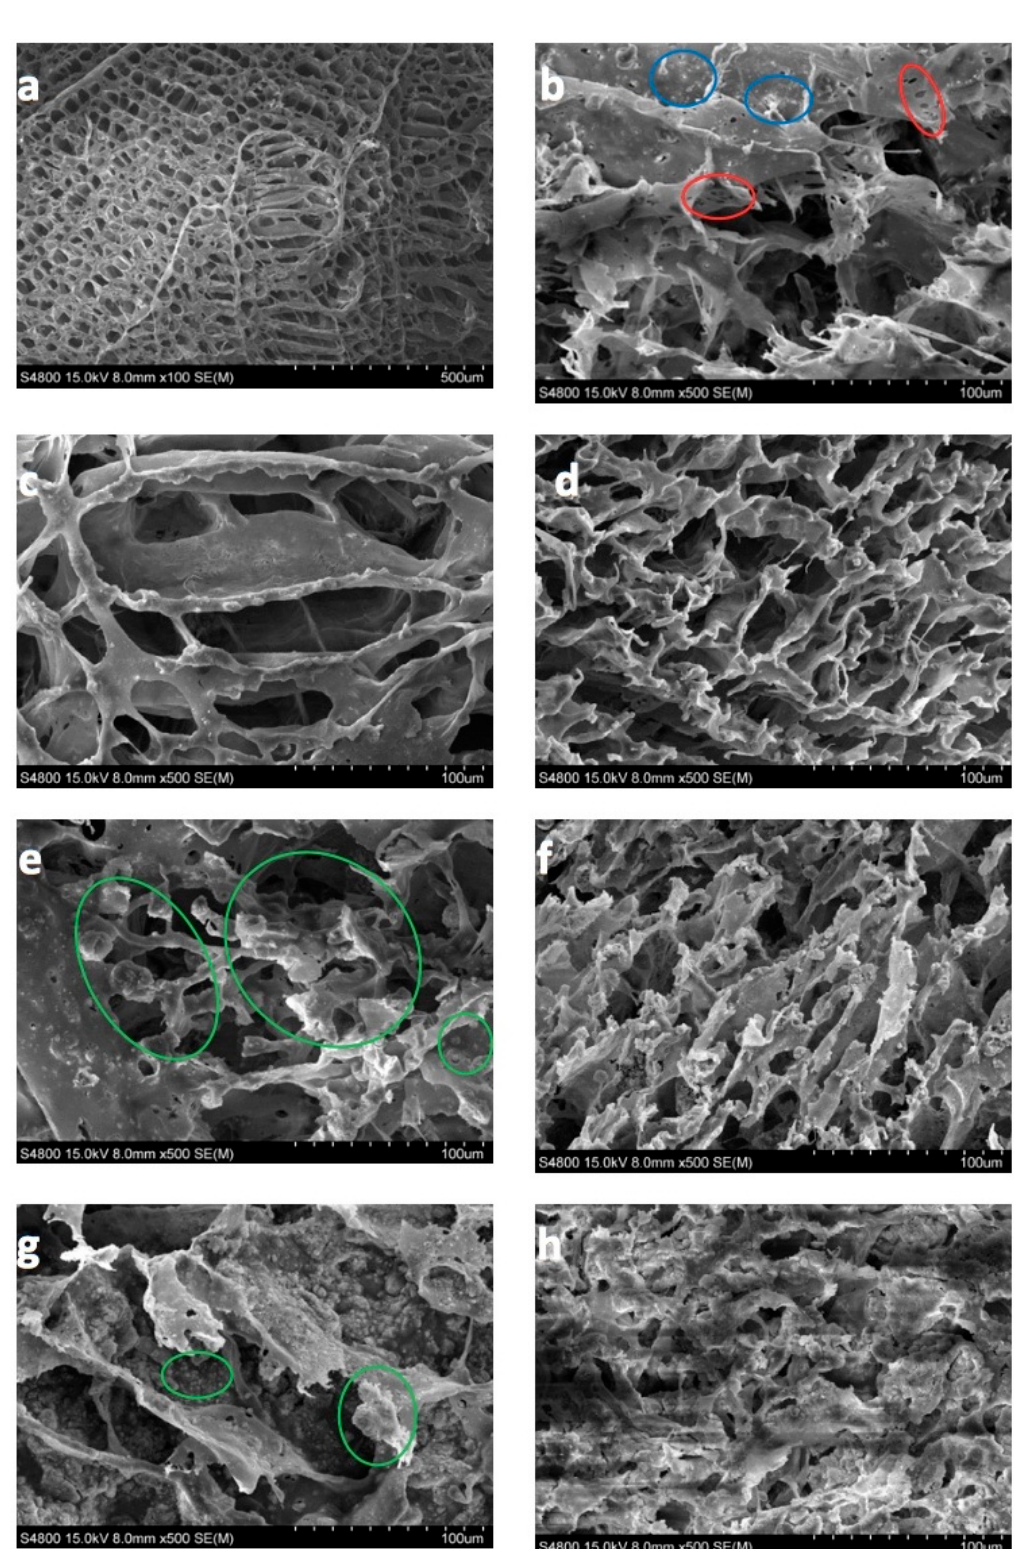
Figure 5. 100 × magnification SEM micrographs of: ( a ) PLLA as prepared, ( b ) PLLA-30% FeHA after 8 weeks degradation, ( c ) PLLA-10% FeHA as prepared, ( d ) PLLA-10% FeHA after 25 weeks degradation, ( e ) PLLA-30% FeHA as prepared, ( f ) PLLA-30% FeHA after 25 weeks degradation, ( g ) PLLA-70% FeHA as prepared, ( h ) PLLA-70% FeHA after 25 weeks degradation.